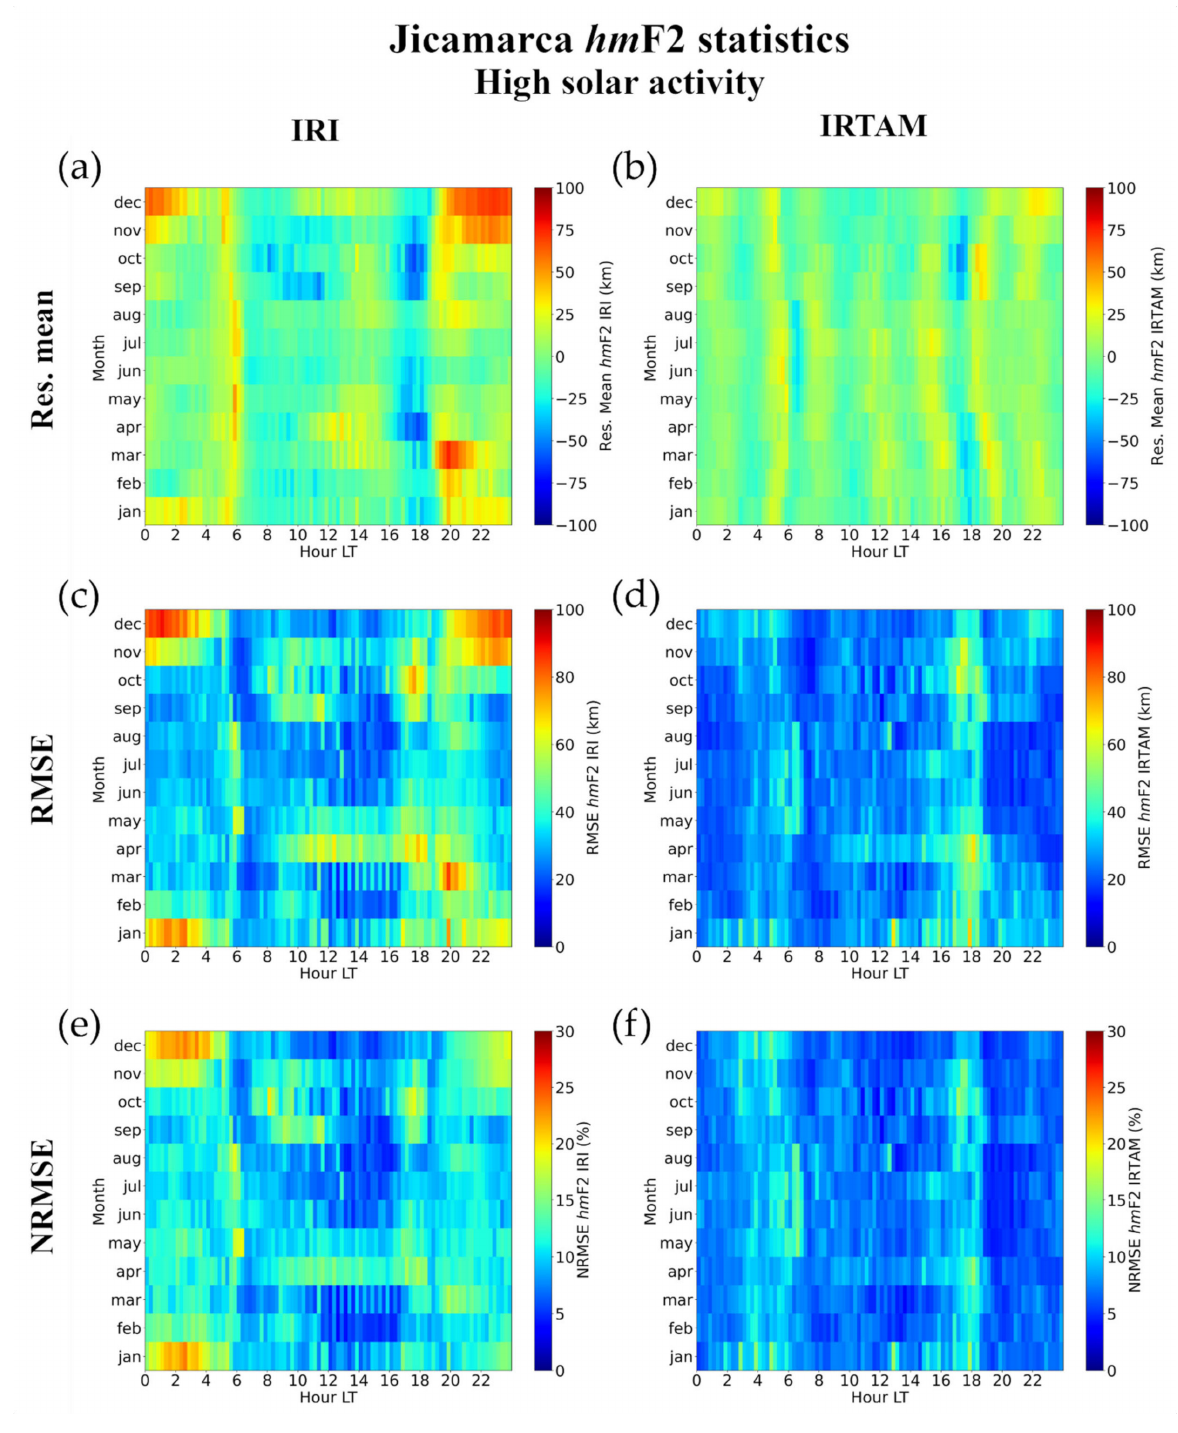
Figure 27. Same as Figure 25 but for HSA